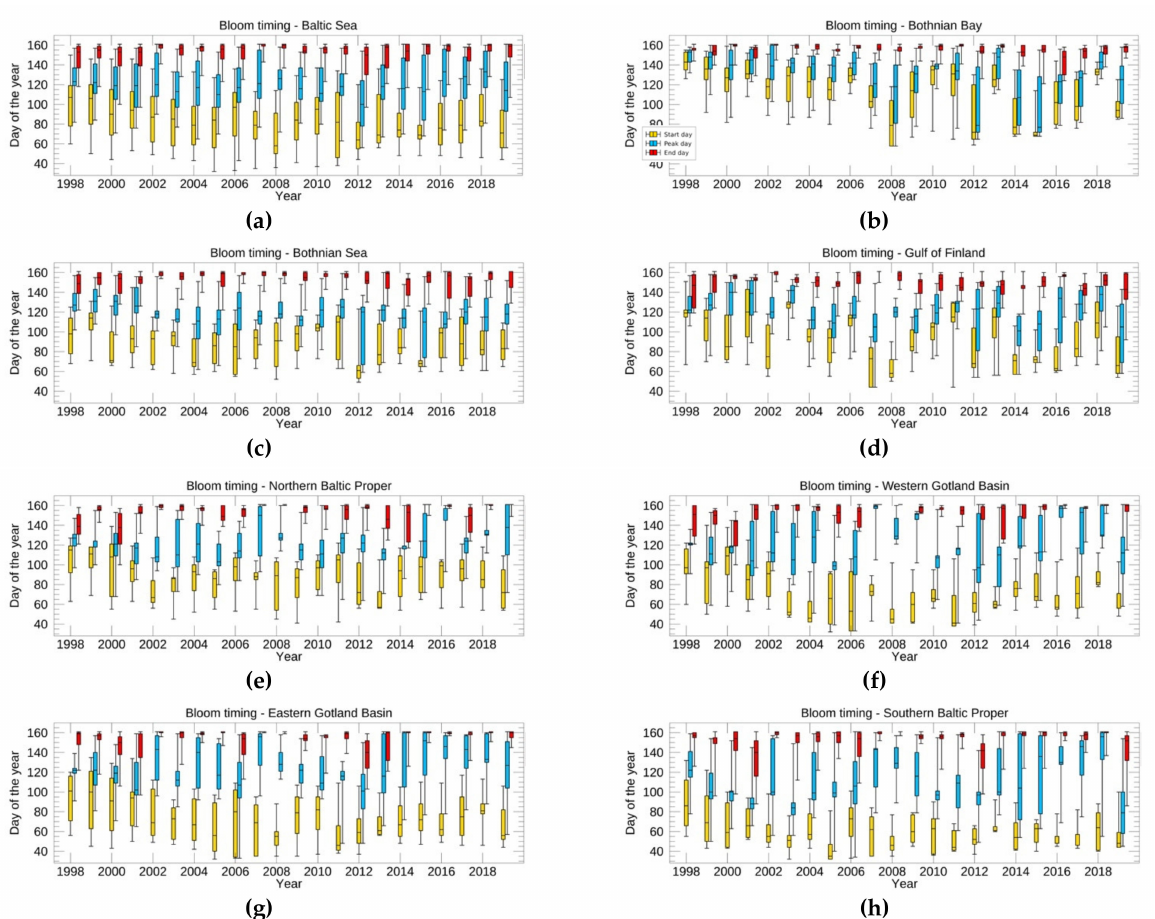
Figure 9. Spring bloom timing across the main sub-basins of the Baltic Sea. The distribution of start, peak, and end days are represented with box and whisker plots: the box represents the interquartile range (i.e., the 25th and 75th percentiles), the median is the bar, while the two whiskers represent the earliest and latest dates (5th and 95th percentiles). ( a ) Whole Baltic Sea, ( b ) Bothnian Bay, ( c ) Bothnian Sea, ( d ) Gulf of Finland, ( e ) Northern Baltic Proper, ( f ) Western Gotland Basin, ( g ) Eastern Gotland Basin, and ( h ) Southern Baltic